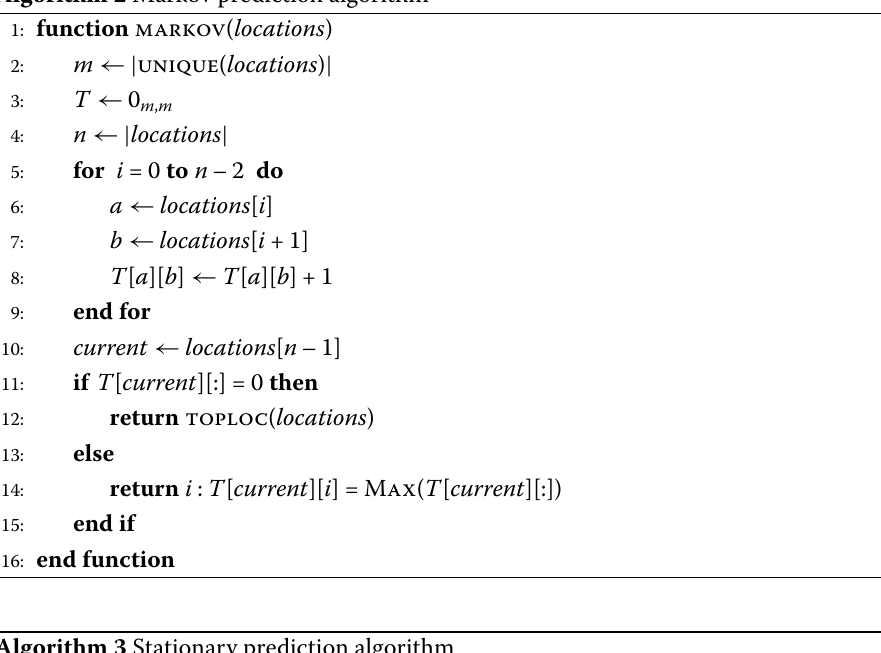
Algorithm 2 Markov prediction algorithm